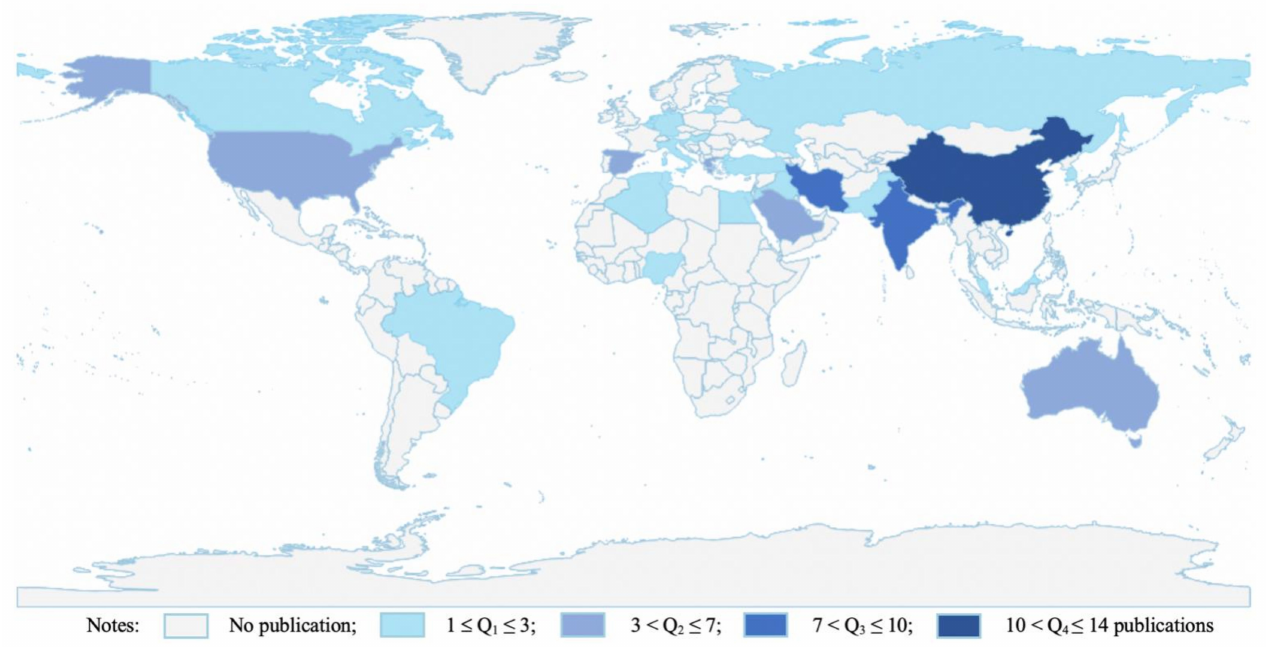
Figure 2. Spatial distribution of publications by quartiles among